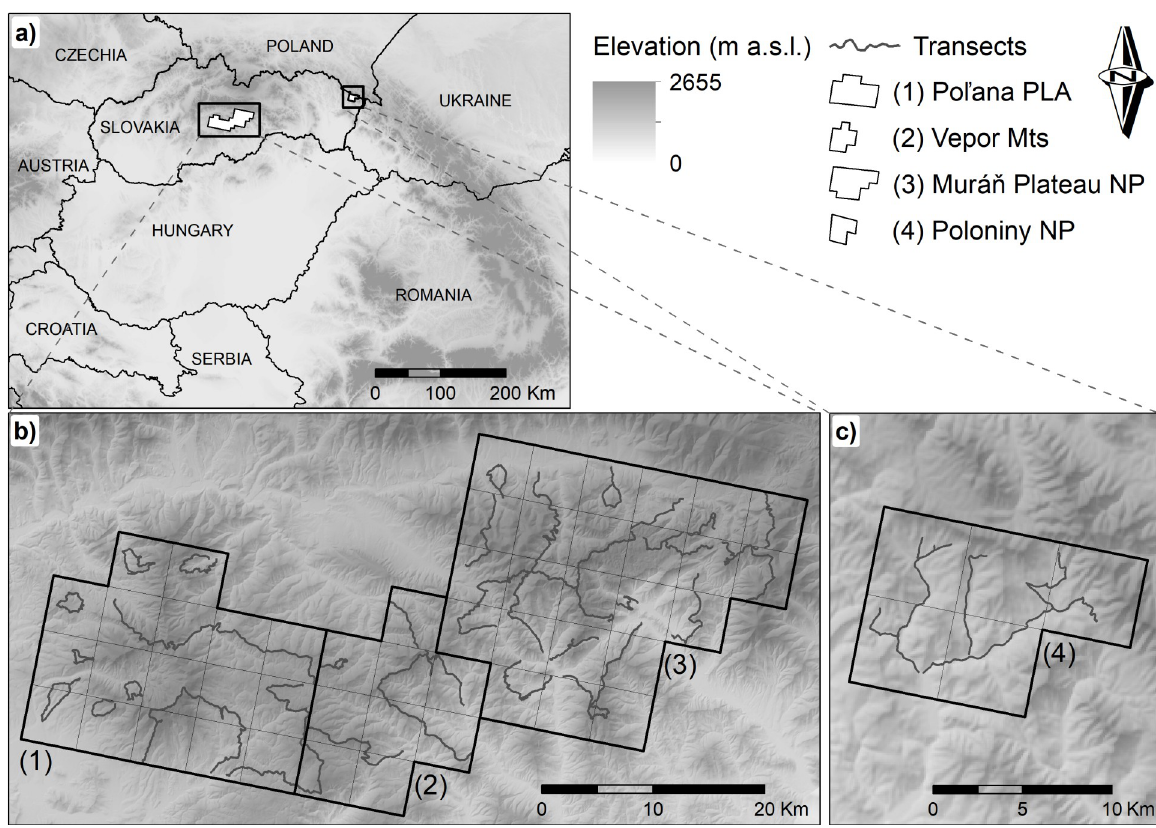
Fig 1. Study area. Location of the four study areas where wolf scats were collected within the Slovak Carpathians (a), and the network of transects used for winter scat collection between 2015–2017 in each study area (b and c). Study areas: Pol’ana PLA (1), Vepor Mts (2), Mura´ ň Plateau NP (3) and Poloniny NP (4). Reprinted from https://www.geoportal.sk/sk/zbgis/na-stiahnutie/ under a CC BY 4.0 license, with permission from Institute of Geodesy and Cartography Bratislava, original copyright